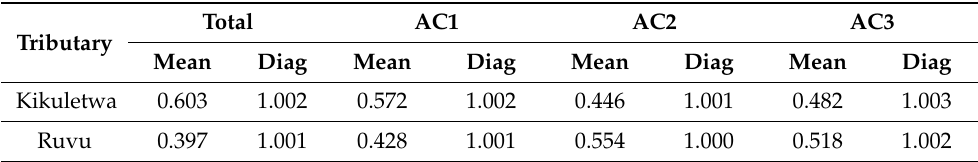
Table A2. The mean values and Gelman diagnostics (Diag.) of the Bayesian Mixing model runs for both ‘total’ and ‘spatial’ model builds.